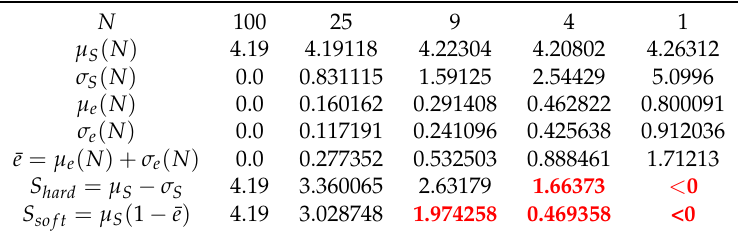
Table 4. Results for the average trap counts obtained for the beetle population on a sequence of coarse grids from Data Set I in Figure 5. The mean value µ S ( N ) and the standard deviation σ S ( N ) are computed for the average trap count S c on a sequence of quasi-regular grids with number N of sampling locations. For any realisation of the average trap count the error (2) is computed. Given K realisations of error (2), the mean evaluation error µ e ( N ) , the standard deviation σ e ( N ) of the evaluation error, and the upper error bound µ e ( N ) + σ e ( N ) are computed for each N in the table. The estimated values of the average trap count that falls below the hypothetical management point (conservation target) of S ∗ = 2 beetles per trap are shown in